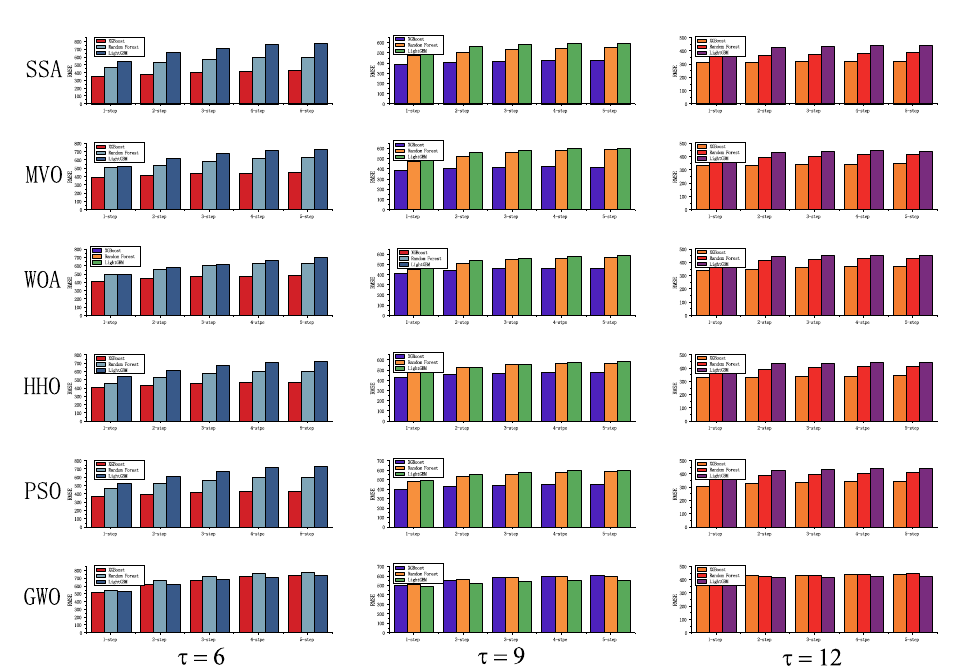
Figure 15. RMSEs of XGBoost, Random Forest and LightGBM with multi-step ahead forecasting steps for the UK NGC dataset.